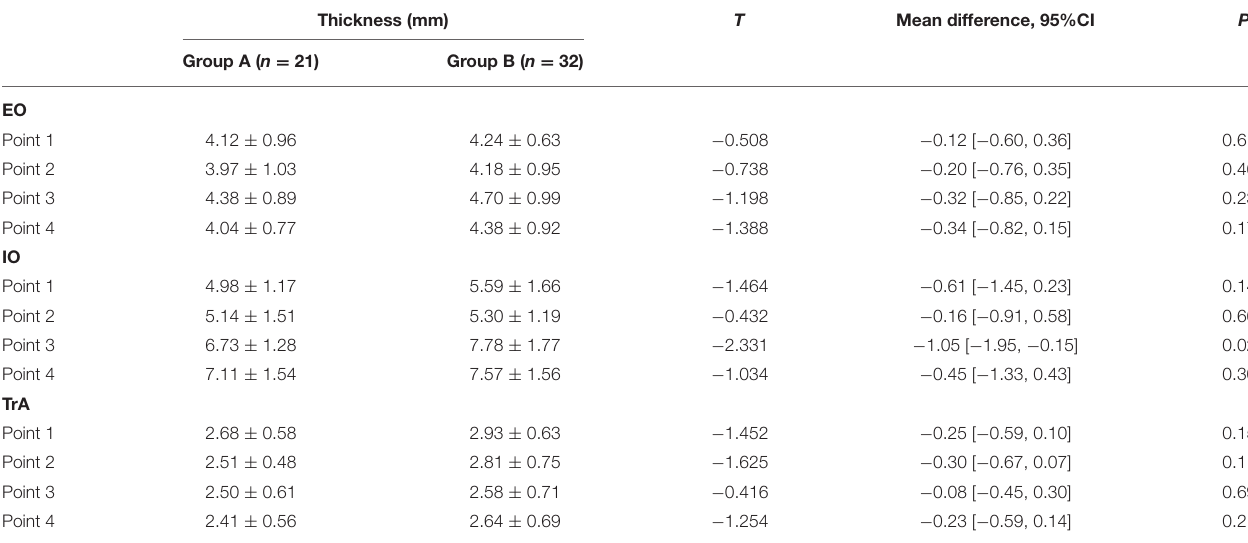
TABLE 2 | Comparison of muscle thickness between group A and group B.